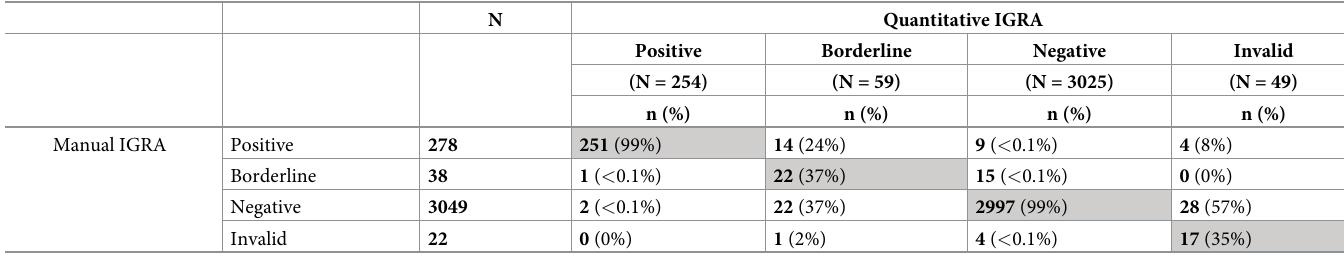
Table 2. Concordance between results obtained by quantitative IGRA and manual